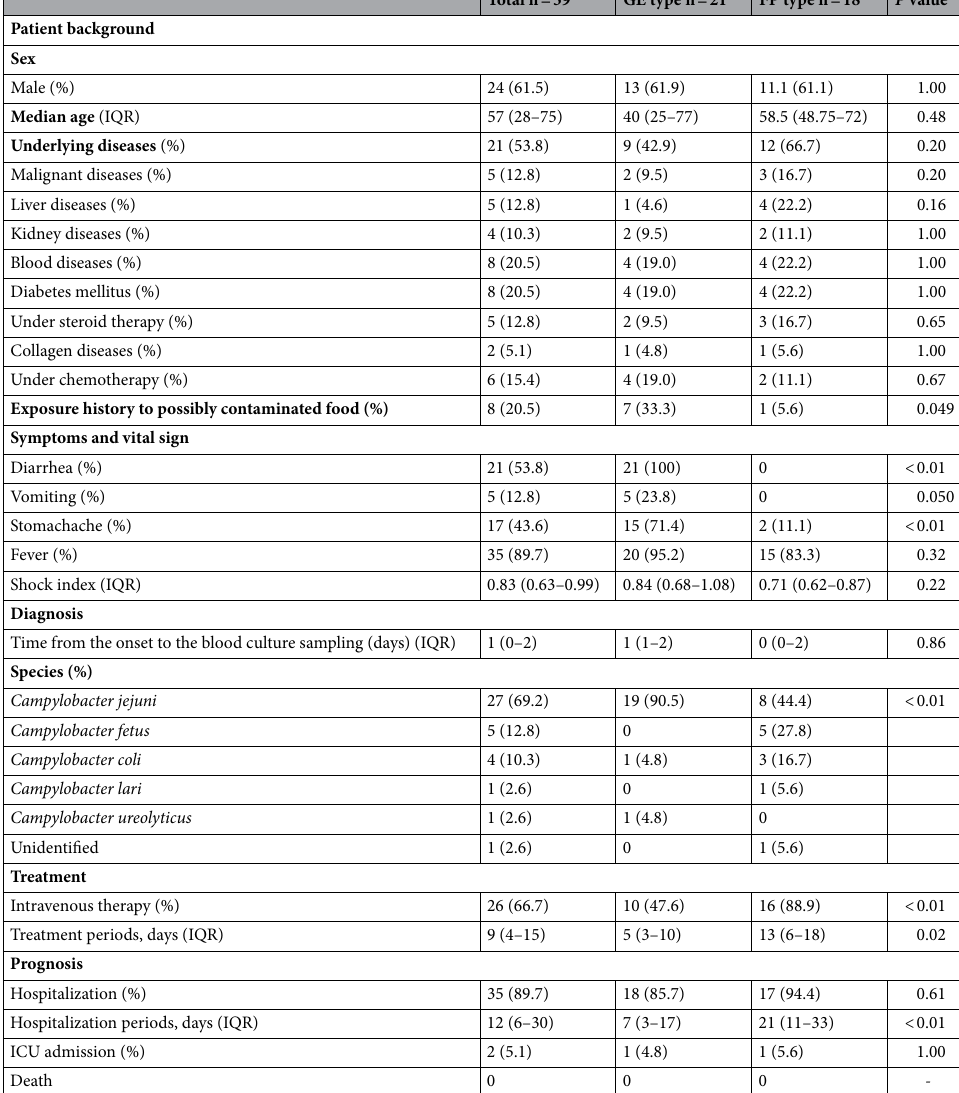
Table 1. Clinical and microbiological summary of patients with Campylobacter bacteremia. The data were analyzed by the Mann-Whitney U test and Fisher’s test, as appropriate. FP fever predominant, GE gastroenteritis, IQR interquartile range, ICU intensive care